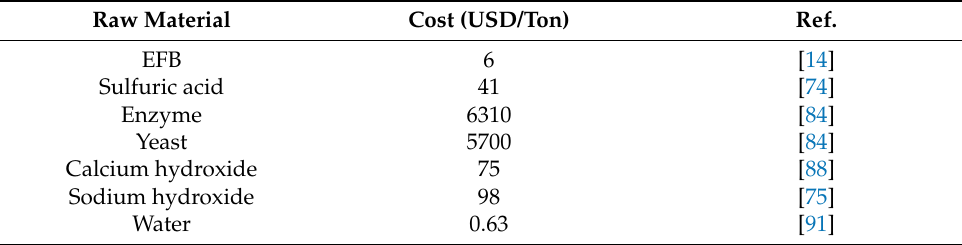
Table 5. Cost of raw